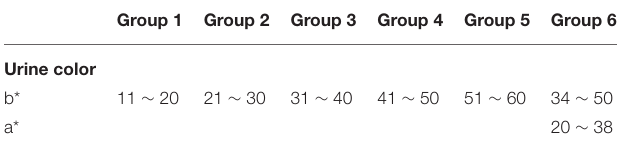
TABLE 1 | Grouping criteria of urine